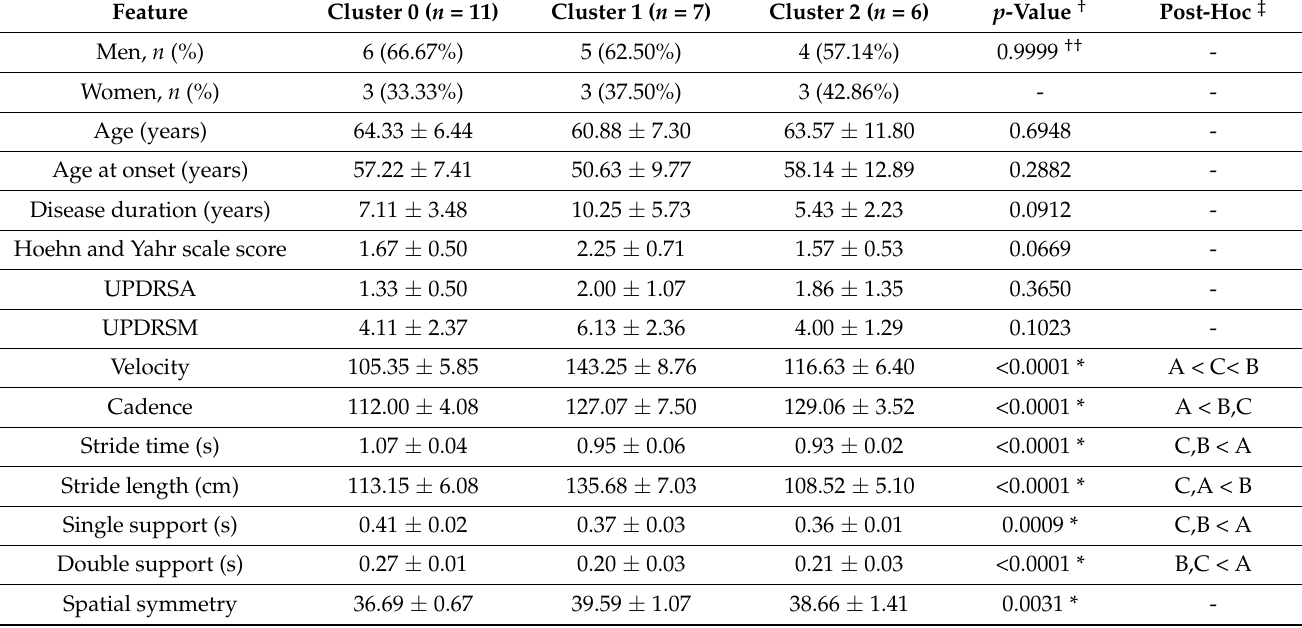
Table 4. Mean and standard deviation of the seven features with three clusters.